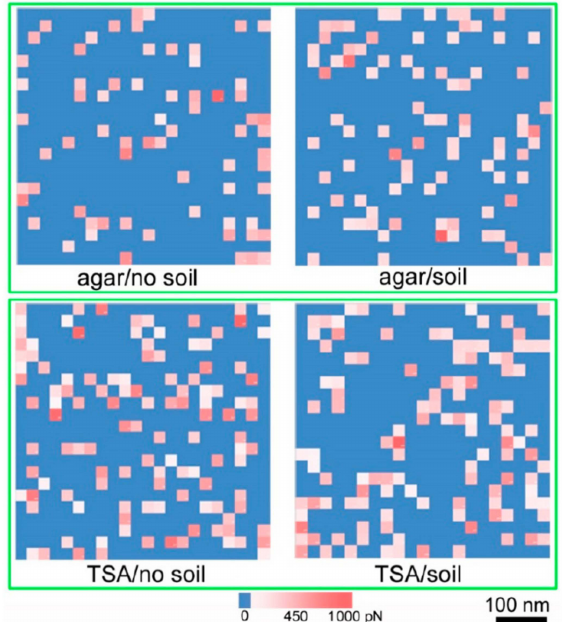
Figure 4. Surface hydrophobicity maps of Yersinia pestis cell surfaces grown under di ff erent conditions in the 3D printed culture chamber. The cell surfaces were probed with a hydrophobic AFM tip. The maps are color coded as blue = no interaction with tip, white to red = increasing interaction force with tip (ranging from 200 pN to 1 nN). The points are ~25 nm apart, thereby each square presents a profile of a 0.5 µ m 2 area of the cell (scale bar = 100 nm). The number of non-blue areas are representative of the points of interaction (hydrophobic groups) on the cell surface.